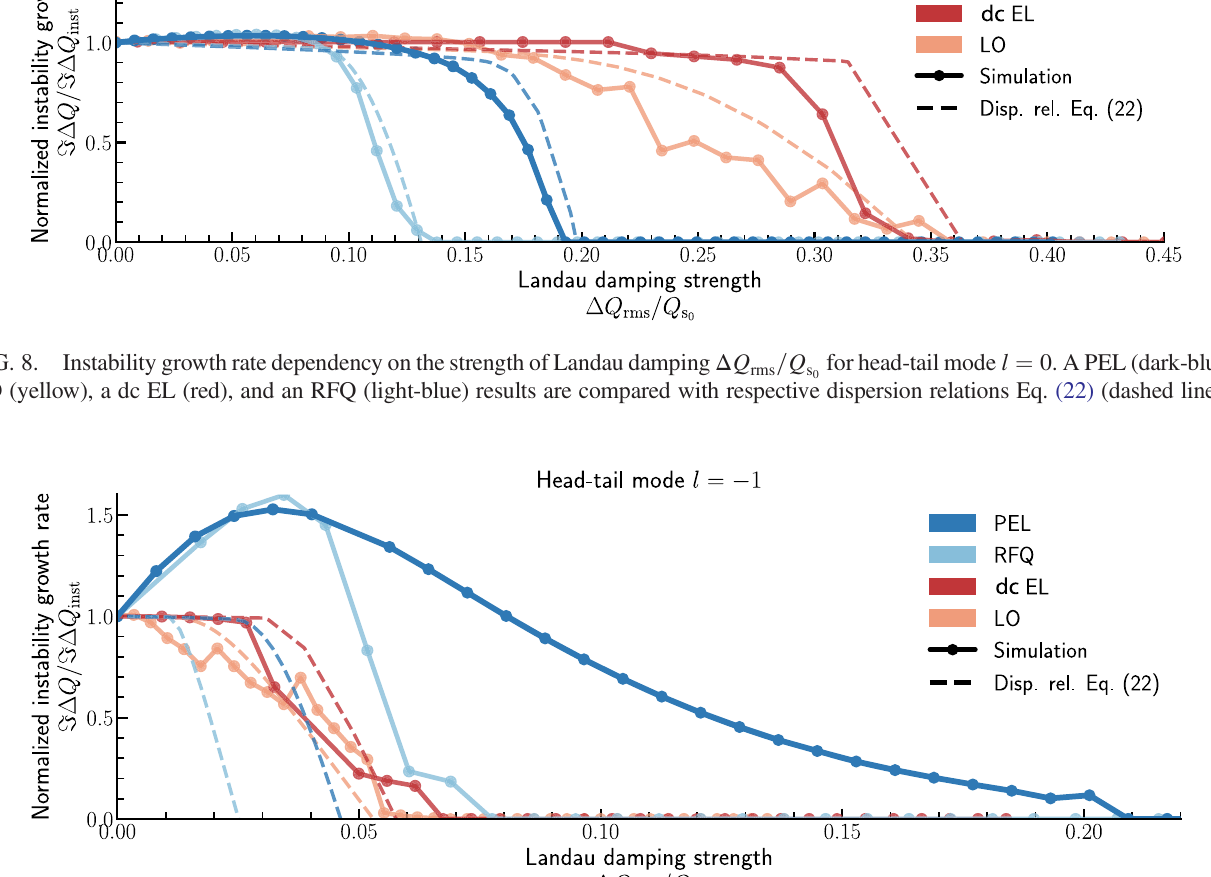
FIG. 9. Instability growthratedependency onthe strength of Landau damping Δ Q LO (yellow), a dc EL (red), and an RFQ (light-blue) results are compared with respective dispersion relations Eq. (22) (dashed lines).